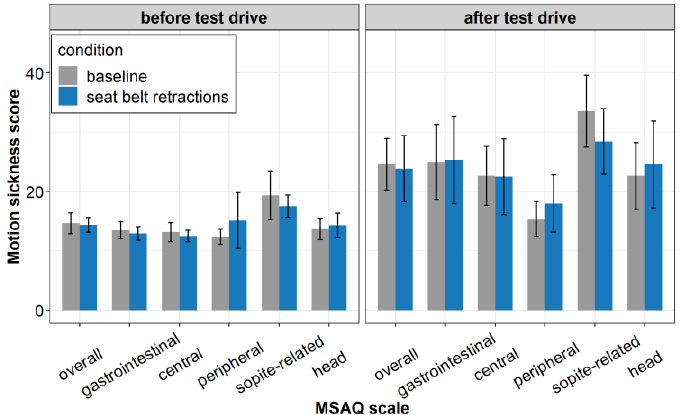
Figure 9. Means of MSAQ motion sickness ratings before and after the test drive in the baseline and with seat belt retractions. Error bars display 95% confidence intervals. with seat belt retractions. Error bars display 95% confidence